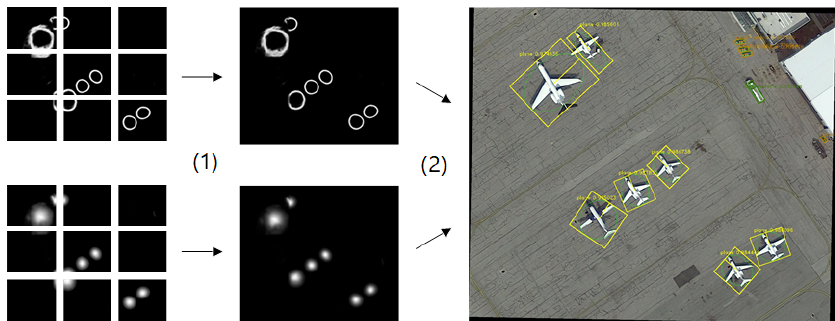
Figure 5. Spray painting can splice small field images into large ones and, then, obtain a bounding box through